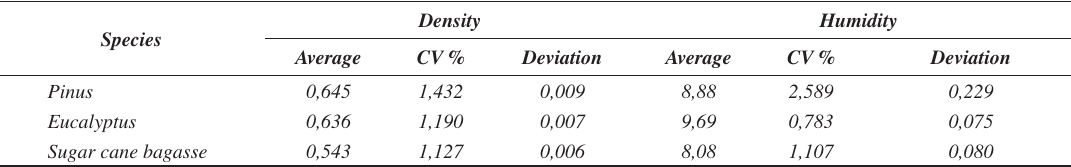
Table 1. Average values of apparent density and humidity of the